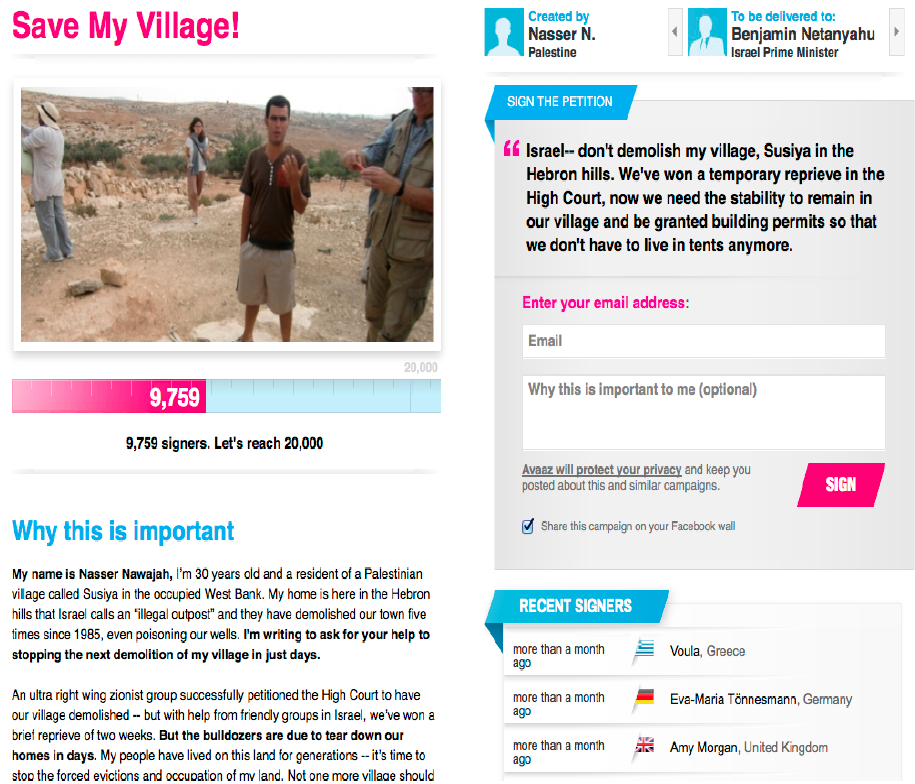
Figure 6. Screen grab of Nasser’s ‘Save my Village’ e-petition (Accessed on 8 November 2015).